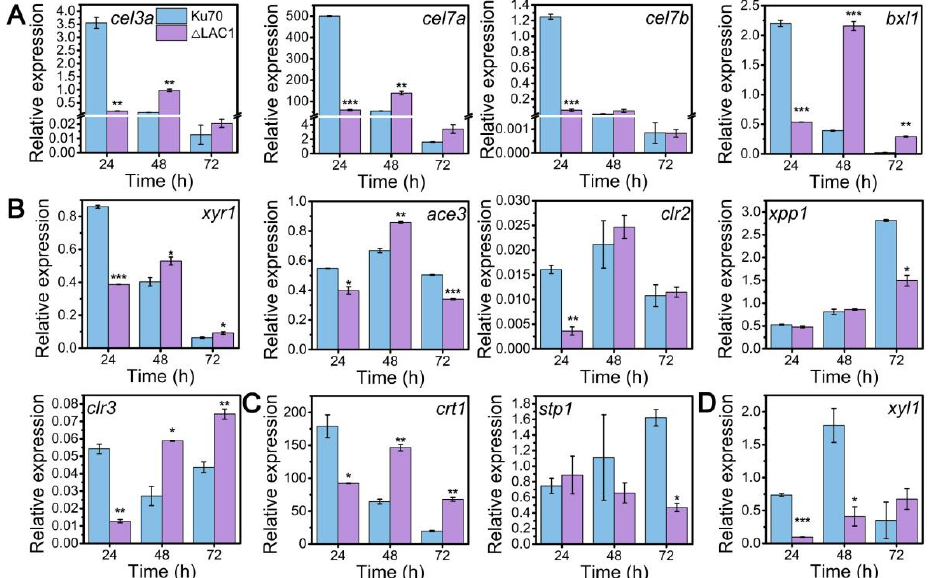
Figure 4. qRT-PCR analysis of the transcript abundance of genes relevant to cellulase and hemicellulase production in T. reesei Δku70 and Δlac1 grown on 2% lactose for 72 h including genes involved in (A) cellulase and hemicellulase production, (B) transcription factors, (C) sugar transportation, and (D) lactose metabolism. Values are the means of three biological replicates, and error bars are the standard deviations of these three replicates. The gene expression level was calculated using the 2 −ΔCt method. The relative mRNA level of each tested gene was normalized to the housekeeping gene sar1 . * p < 0.05, ** p < 0.01, and *** p < 0.001. To visualize the protein LAC1 in T. reesei , the overexpression of LAC1-DsRed under the strong promoter cbh1 was carried out, leading to the recombinant strain LAC1-DsRed-OE. Strain LAC1-DsRed-OE displayed red fluorescence in perinuclear ER rings and vacuoles, similar to strain MFS-DsRed. This suggests that LAC1 was distributed in perinuclear ER rings and vacuoles in T. reesei grown on lactose. Moreover, the red fluorescence at the apical regions of the recombinant strains MFS-DsRed, GST-DsRed, and LAC1-DsRed-OE was not stronger than that at the subapical areas, showing that all three sugar transporters were not accumulated at the apical regions (Figure